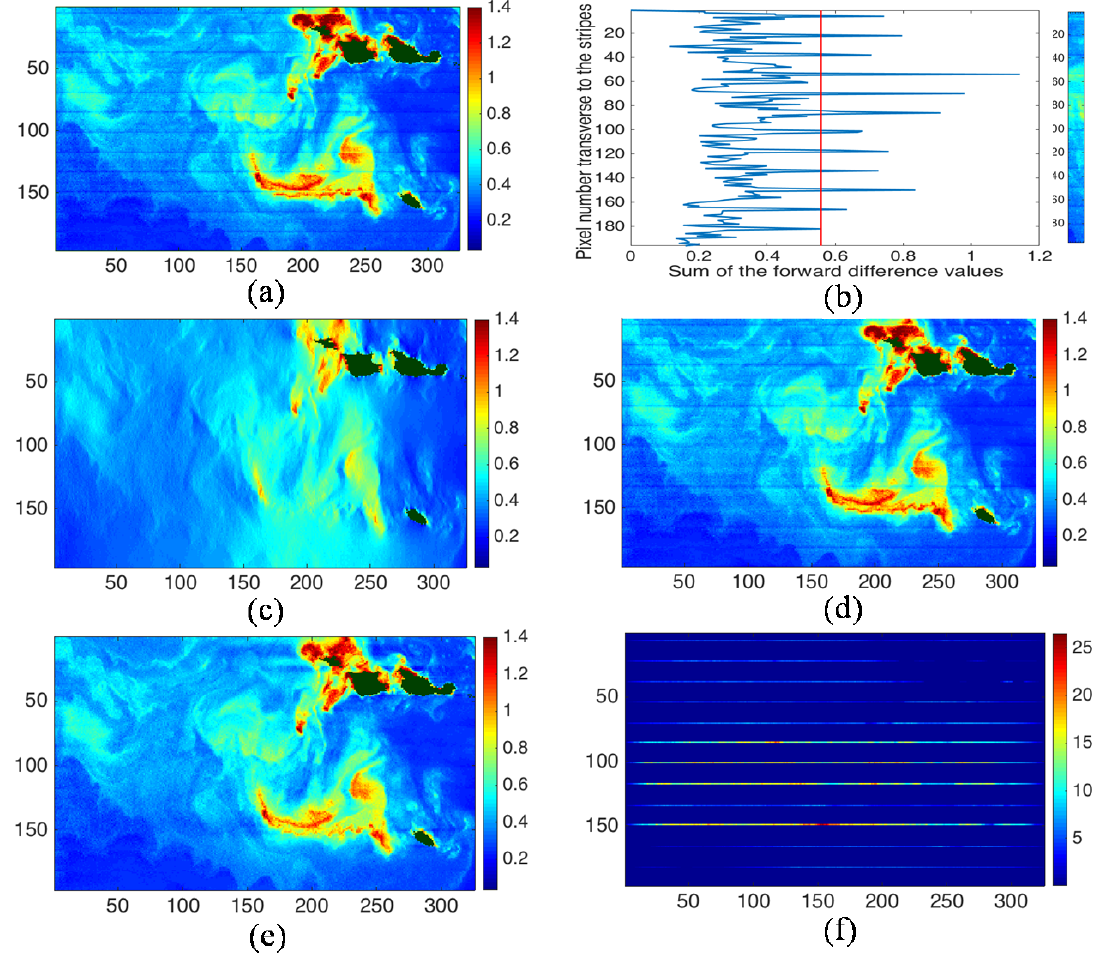
Figure 7. Panel (a) shows the cropped region shown in Fig. 6 and the graph (b) shows the S curve with the threshold and the image piece (columns 137 to 148) that we used compute the values of S curve. The panels (c) , (d) and (e) represent the destriped images of (a) with α = 1 with unweighted regularization term and α = 10 − 5 and α = 10 − 2 with weighted regularization term, respectively. Panel (e) provides the best solution for the destriped image. Panel (c) is over regularized whereas panel (d) is not sufficiently regularized. Panel (f) represents the percentage error between panels (a) and (e)